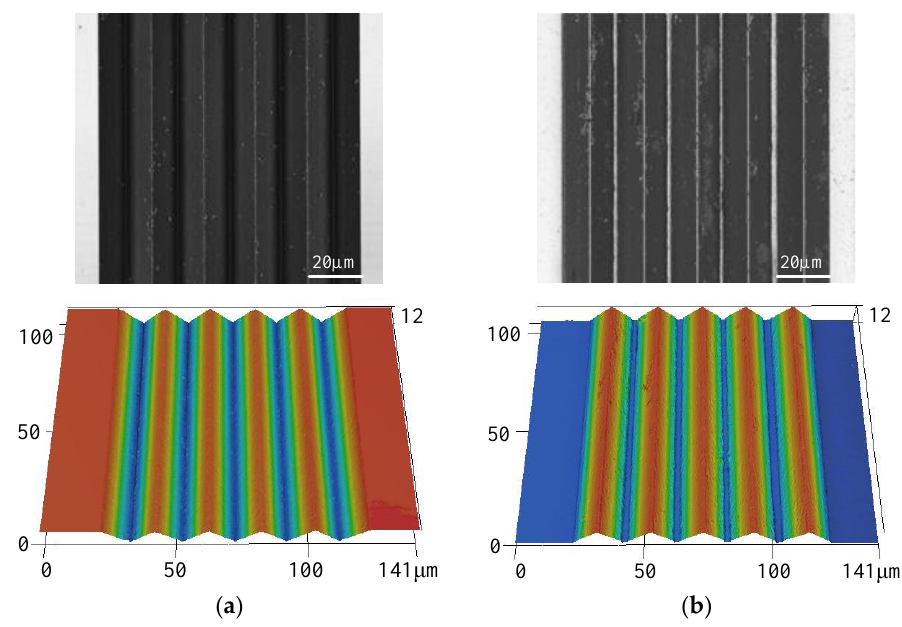
Figure 27. The contour curves of the microstructures on the ChG surface and mold surface are extracted